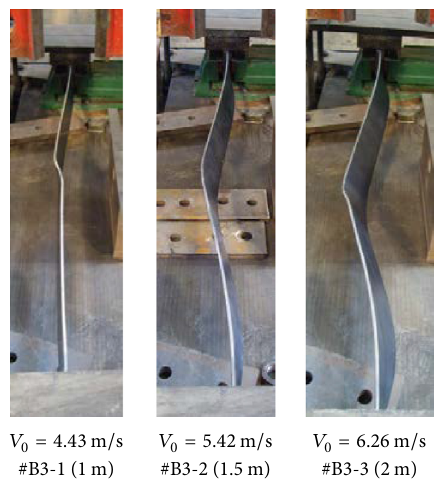
Figure 13: Deformation modes of #C2 (𝛼 = 20, 𝛽 = 15) .